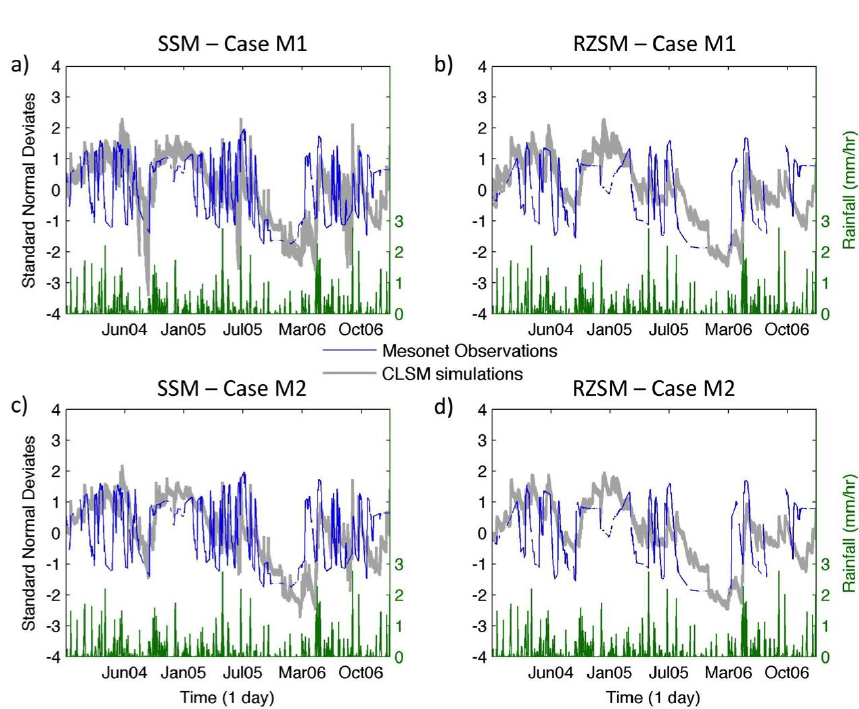
Fig. 5. Standard-normal deviate time series for a representative Mesonet station located in the eastern region of the study area (94.845 ◦ W– 36.889 ◦ N, see Fig. 1) and for the corresponding 25km grid cell. Panels (a) and (b) illustrate model simulations in which parameters are perturbed, while panels (c) and (d) illustrate model simulations in which model prognostic variables are perturbed. Surface (a, c) and root zone (b, d) soil moisture time series are shown.